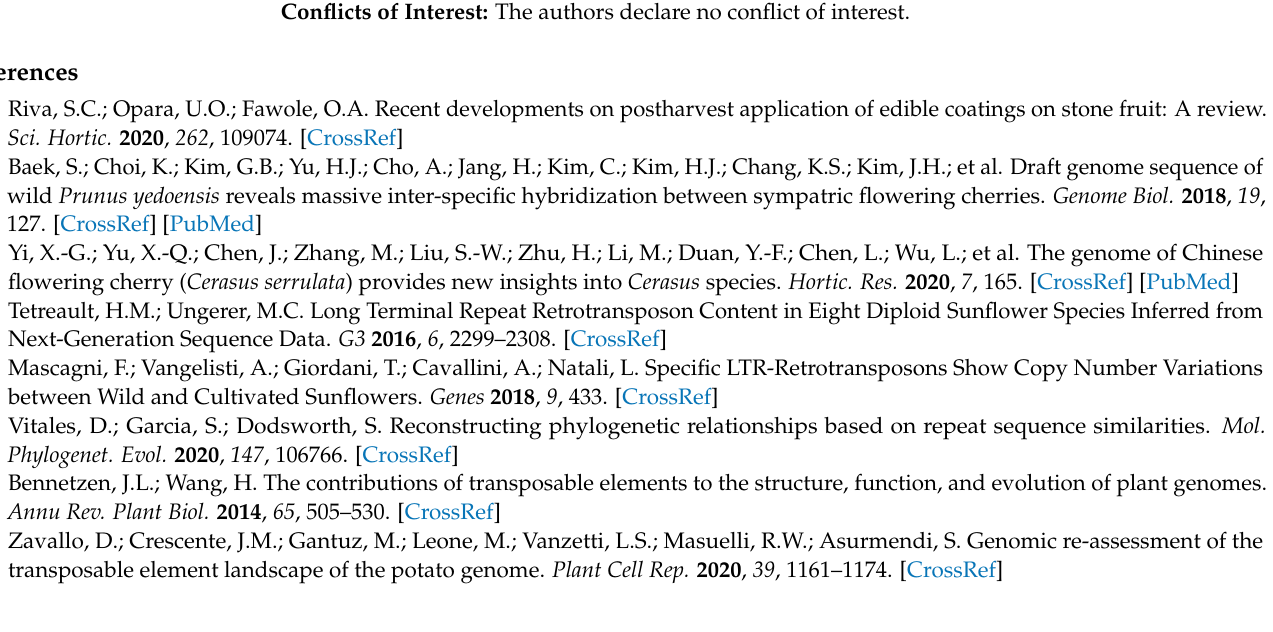
species. Figure S2: Distribution of the distance between full-length LTR-RTs and genes across the species. Figure S3: Dot plots of the identified satellite repeat sequences with monomer units of 166 bp. Figure S4: Chromosomal distribution and concentration comparison of oligonucleotide dye in 13 accessions from ten Prunus subgenus Cerasus species and related taxa. Figure S5: Alignment of the protein sequences of CENH3 from eight Prunus subgenus Cerasus and relatives. Table S1: Overview of the assembly quality and characteristics of the genomes from the Prunus subgenus Cerasus and its relatives. Table S2: The sequence reads of materials from high-throughput sequencing were used for satellite DNA identification. Table S3: Summary of TE libraries constructed with the haploid genomes of the Prunus subgenus Cerasus . Table S4: Statistics of full-length LTR-RTs in the nine haploid genomes of the Prunus subgenus Cerasus and its relatives. Table S5: The number of total full-length LTR-RT clusters among different taxa. Table S6: The number of full-length LTR-RT clusters containing more than ten copies within families. Table S7: Summary of the satellite DNAs identified by TAREAN. Table S8: The 166 bp monomer units identified in this study. Table S9: The content and proportion of all tandem repeats, centromere-associated repeats and telomeres in nine haploid genomes of eight taxa from the Prunus subgenus Cerasus and its